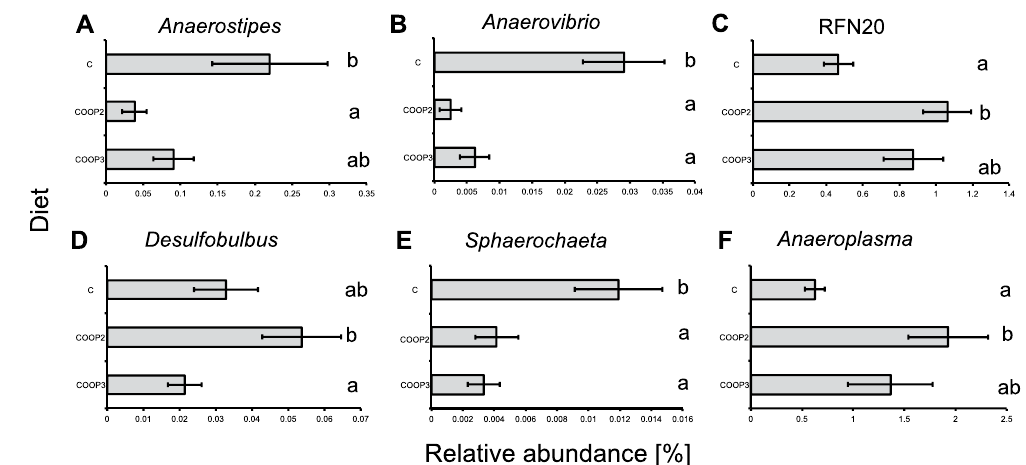
Figure 2. Effect of OOPs at genus level. Each bar is labeled respective to the ewe dietary regimen (C = control diet; COOP2 = control diet added with olive oil pomace extracted with a two-phase procedure; COOP3 = control diet added with olive oil pomace extracted with a three-phase procedure). Bacterial genera influenced by diet (ANOVA, p < 0,05): ( A ) Anaerostipes , ( B ) Anaerovibrio , ( C ) RFN20 genus, ( D ) Desulfobulbus , ( E ) Sphaerochaeta and ( F ) Anaeroplasma . Means sharing the same letter are not significantly different (post hoc Tukey’s HSD